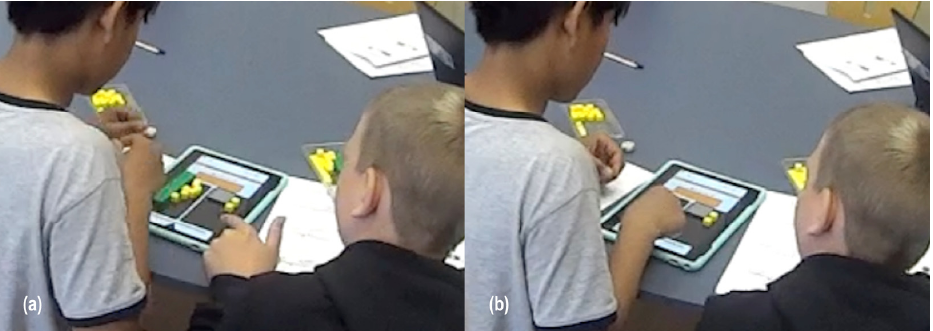
Figure 6. Peer scaffolding. ( a ) St 23 (B) (on the right) explaining to St 24 (C) (on the left) how to solve the equation. ( b ) St 24 (C) removing base-10 blocks from the digital scale to solve the equation, while St 23 (B) observes what St 24 (C) is doing.